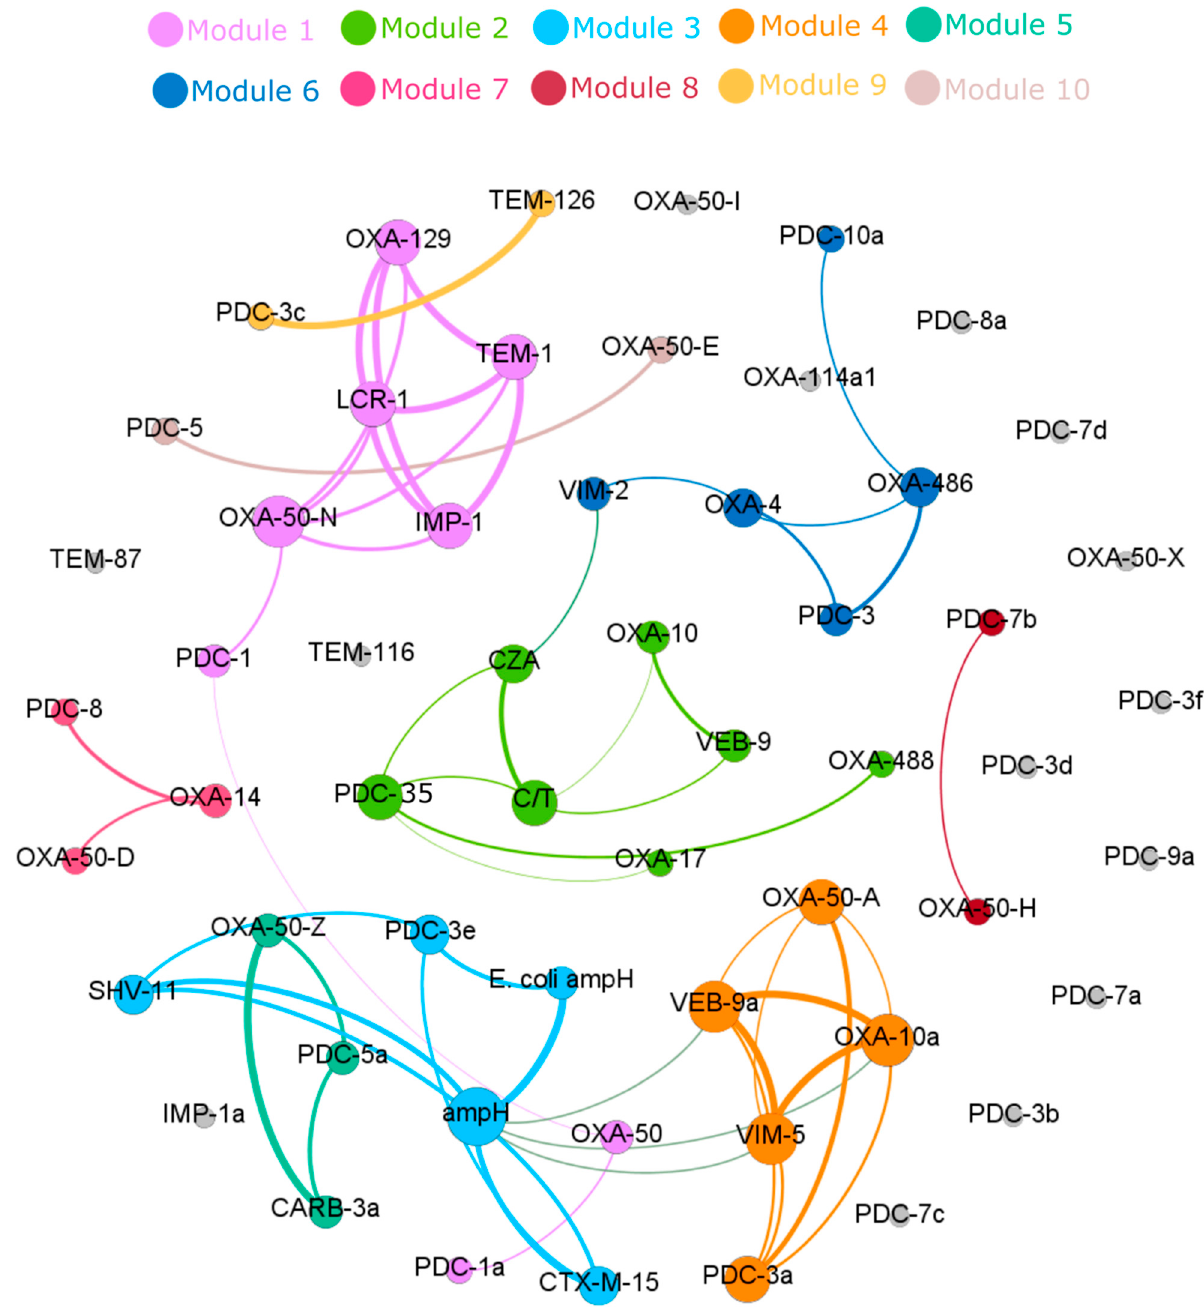
Figure 3. The co-occurrence network based on the Spearman’s correlation of all β -lactamase genes and resistance phenotypes in 75 MDR- P. aeruginosa strains, performed and visualized by Gephi network analysis ( p ≥ 0.4). The node size represents the number of connections with other antibiotic resistance genes. The thickness of the edge is proportional to Spearman’s correlation coefficient ( p ) of the connection. The co-occurrence network is further divided into 10 subnetworks (modules) based on modularity class (modularity index = 0.477), and modules are highlighted in different colors. Genes in gray color do not show a significant correlation. β -lactamase (amino acid mutation); class CPDC-3a (P7S, G391A), PDC-3b (V205L, G391A), PDC-3c (P7S, V205L), PDC-3d (P7S, V205L,